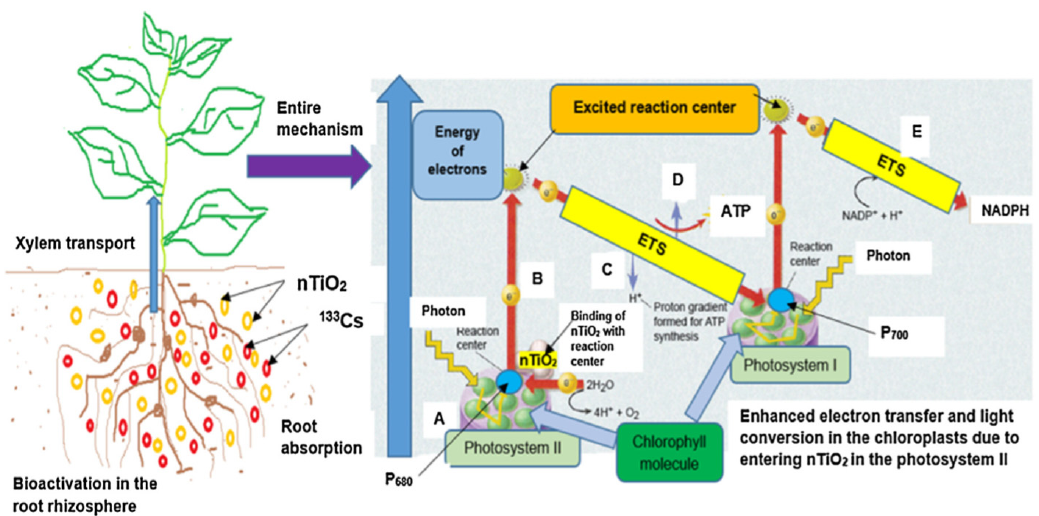
Figure 3. Potential mechanism for improving the accumulation of 133 Cs by the addition of nano-titanium dioxide. Reproduced with permission from [71], Elsevier, 2018.